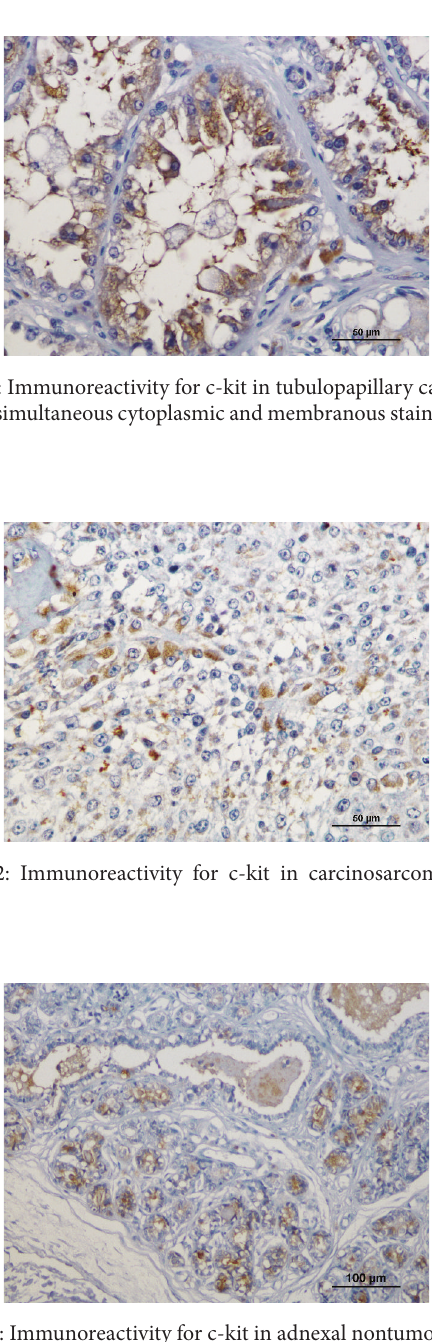
Figure 3: Immunoreactivity for c-kit in adnexal nontumoral mam- mary gland; bar = 100 𝜇